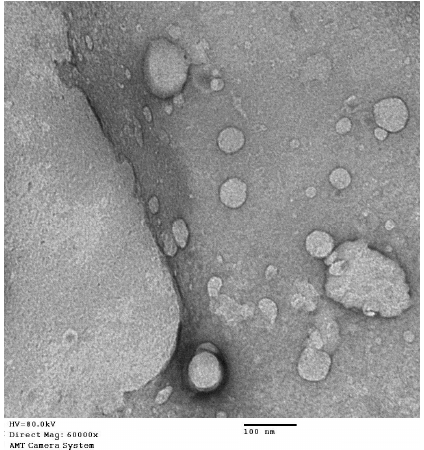
Figure 5. TEM image of the optimized QRT-PHM-SV formulation. QRT-PHM-SV formulation showed potent cytotoxicity to MCF-7 cells: